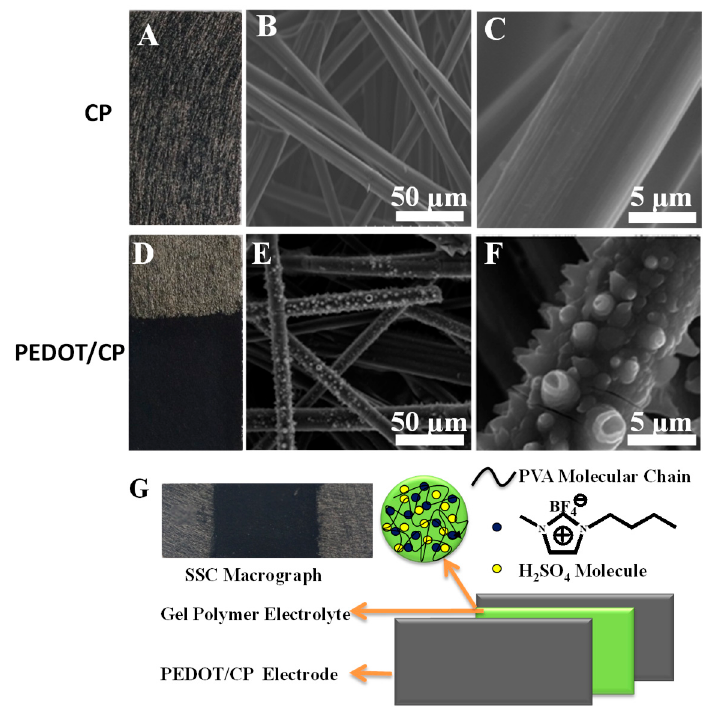
Figure 1. Macrographs and SEM images of the carbon paper ( A – C ) and PEDOT / CP ( D – F ), and the illustration of PEDOT solid-state polymer supercapacitor ( G ).